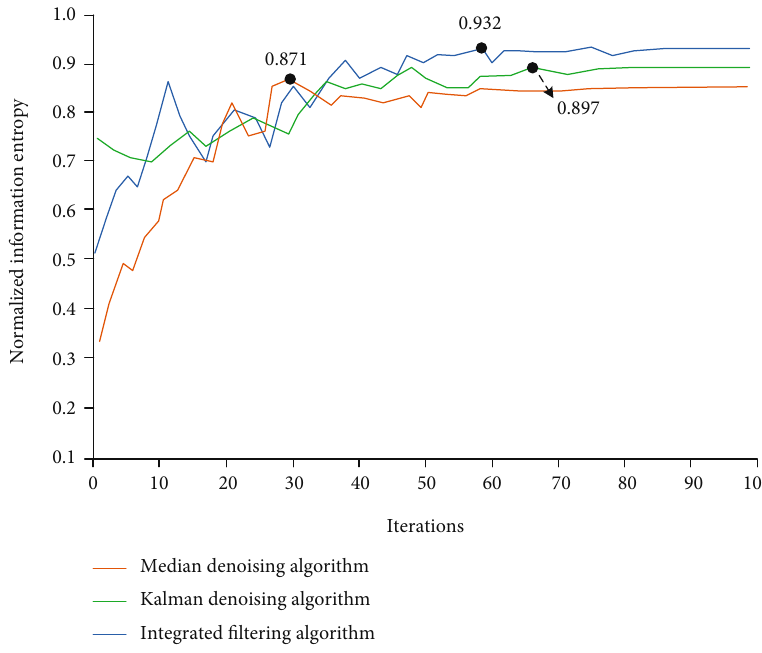
Figure 9: Statistical results of information entropy of each fi ltering algorithm. Table 1: Comparison of computational time consumption of each fi ltering